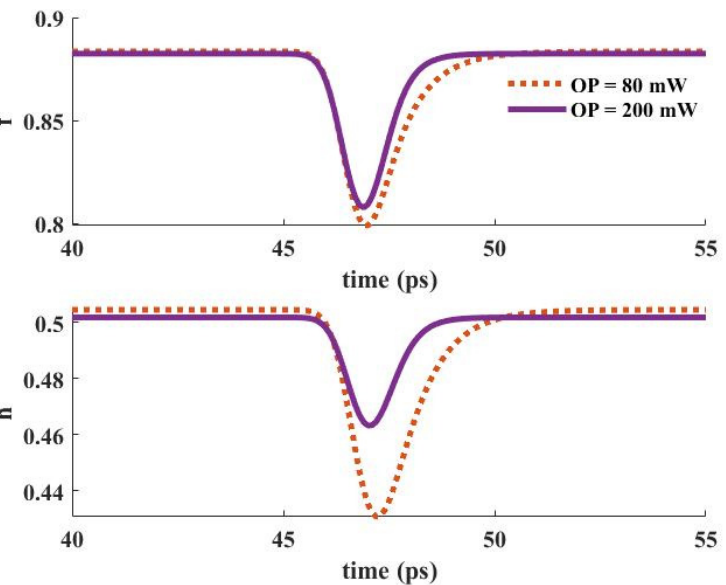
Figure 16. Occupation probability in the ground and excited states versus time for distinct pump powers (input signal power = 1 µ W). f and h can vary between 0 to 1.